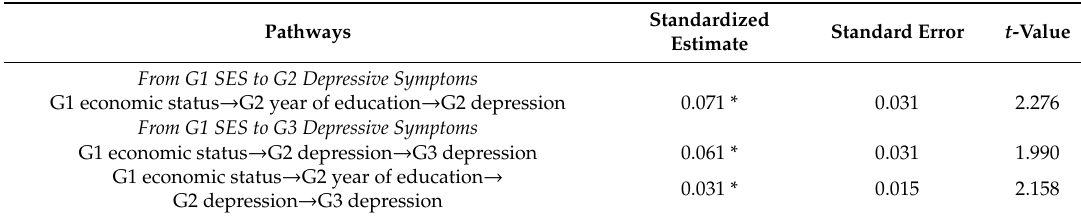
Table 3. Indirect e ff ects for the mediational